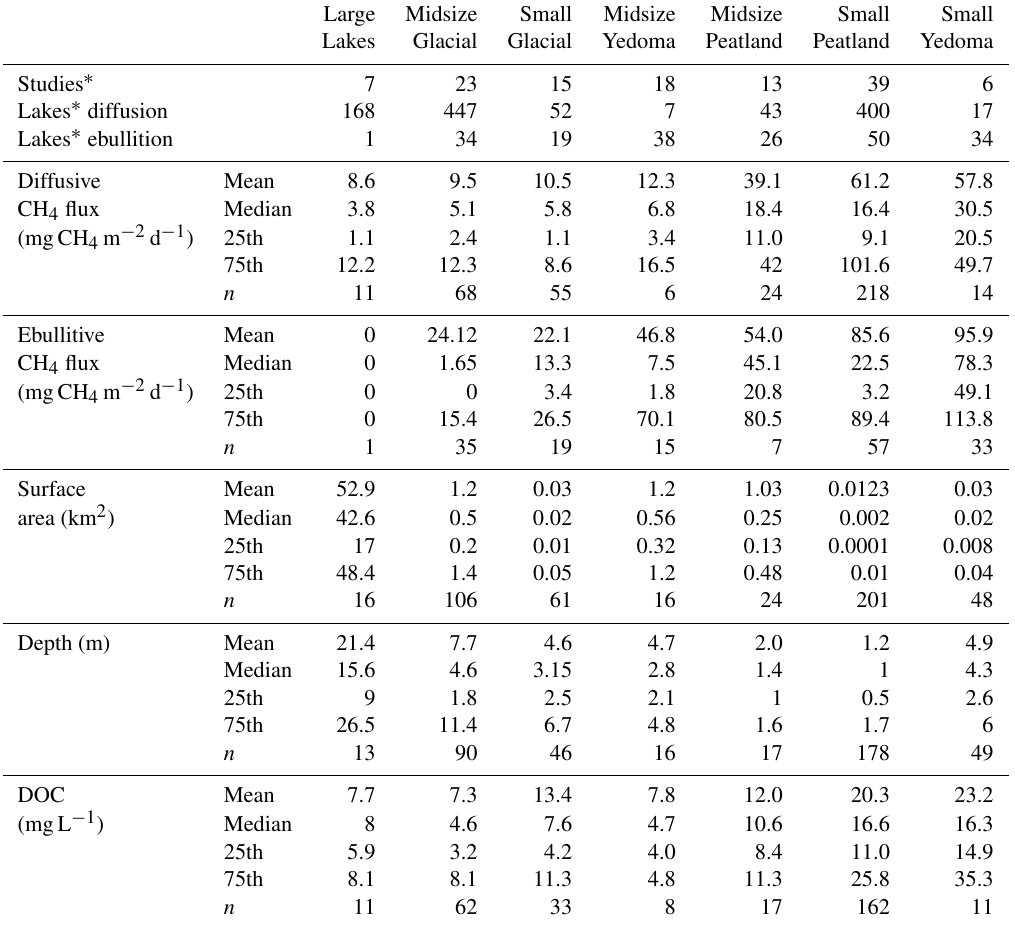
Table 4. Characteristics of the BAWLD aquatic classes based on CH 4 and environmental variables. The number of sites and contributing studies are shown for each class and flux pathway. Also shown are the mean, median, and quartiles for site-average diffusive and ebullitive CH 4 flux, waterbody surface area, waterbody depth, and dissolved organic carbon concentrations (DOC). ∗ In some cases, one study con- tributed flux data for multiple classes and pathway types. One ebullition outlier point (flux = 1815mgCH 4 m 2 d − 1 ) was excluded from the Midsize Glacial class as it was influenced by beaver activity (Sepulveda-Jauregui et al.,